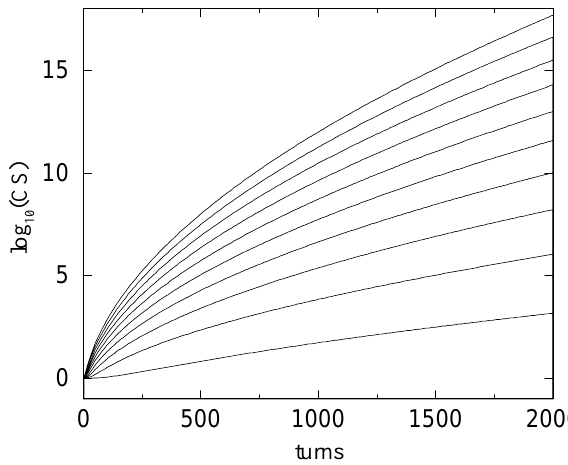
FIG. 6. Log of CS invariants versus turn number for the same conditions as in Fig. 5, except that (cid:81) (cid:115) (cid:173) (cid:48)